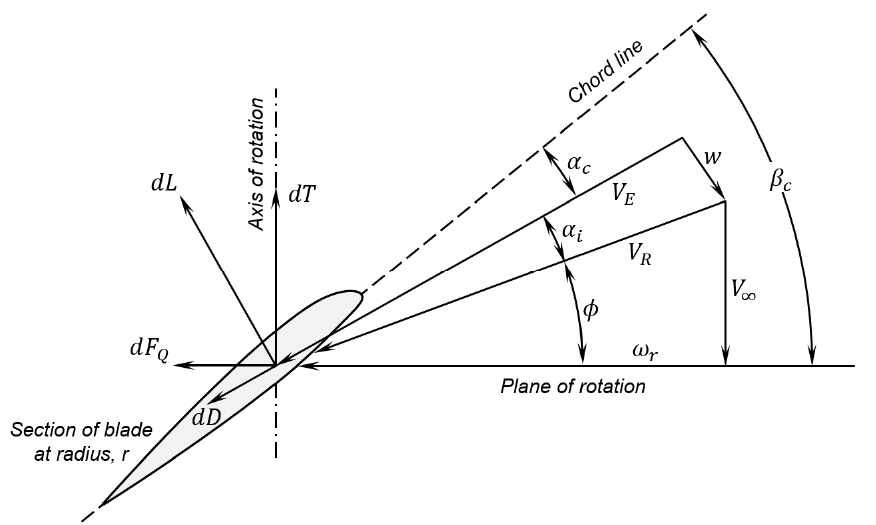
Figure 11. Velocities and forces acting on a propeller blade. Blade element as observed looking in along the blade toward the hub [37].